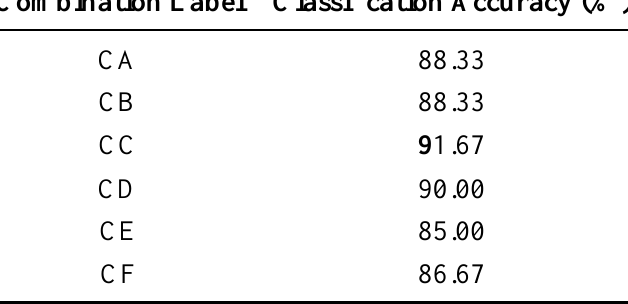
Table 6. Oil palm FFB ripeness classification accuracy for method MA.